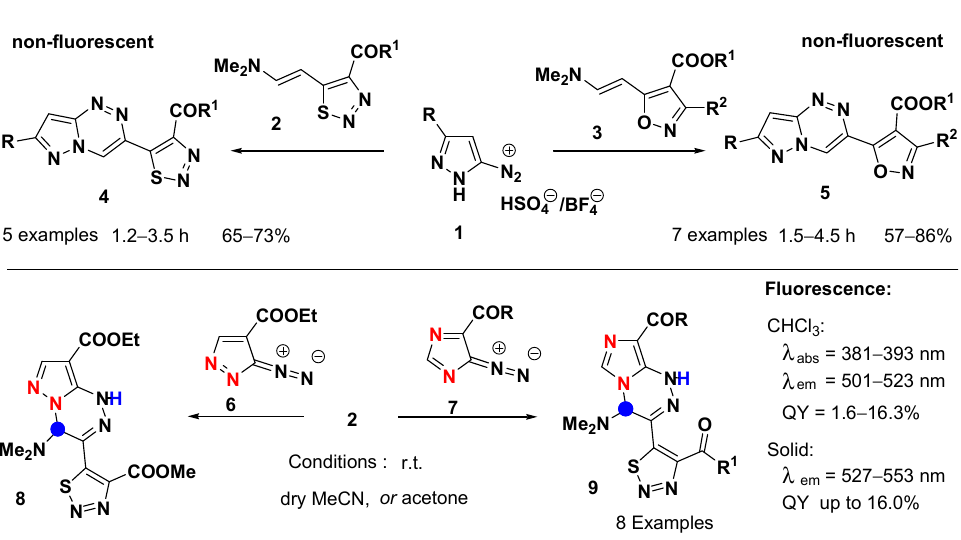
Scheme 1. Strategies for aromatic azolo[5,1- c ][1,2,4]triazines 4 , 5 and non-aromatic DATs 8 , 9 via the reactions of azole diazonium salts 1 or diazoazoles 6 and 7 with heterocyclic enamines.